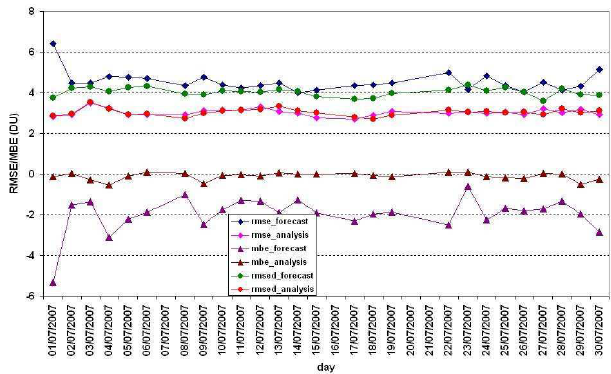
Figure 6. Temporal evolution of the general statistics RMSE, RMSED and MBE calculated for the data described in Figure 5: monthly averaged mean of the ensemble ozone columns (forecast and analysis) versus the IASI partial columns for the whole month. The symbols are as follows: diamonds for the RMSE “forecast” or “analysis” (dark blue or magenta respectively); circles for the debiased RMSE “forecast” or “analysis” (green or red respectively); and triangles for the MBE (violet or brown respectively). The unit measure is DU.